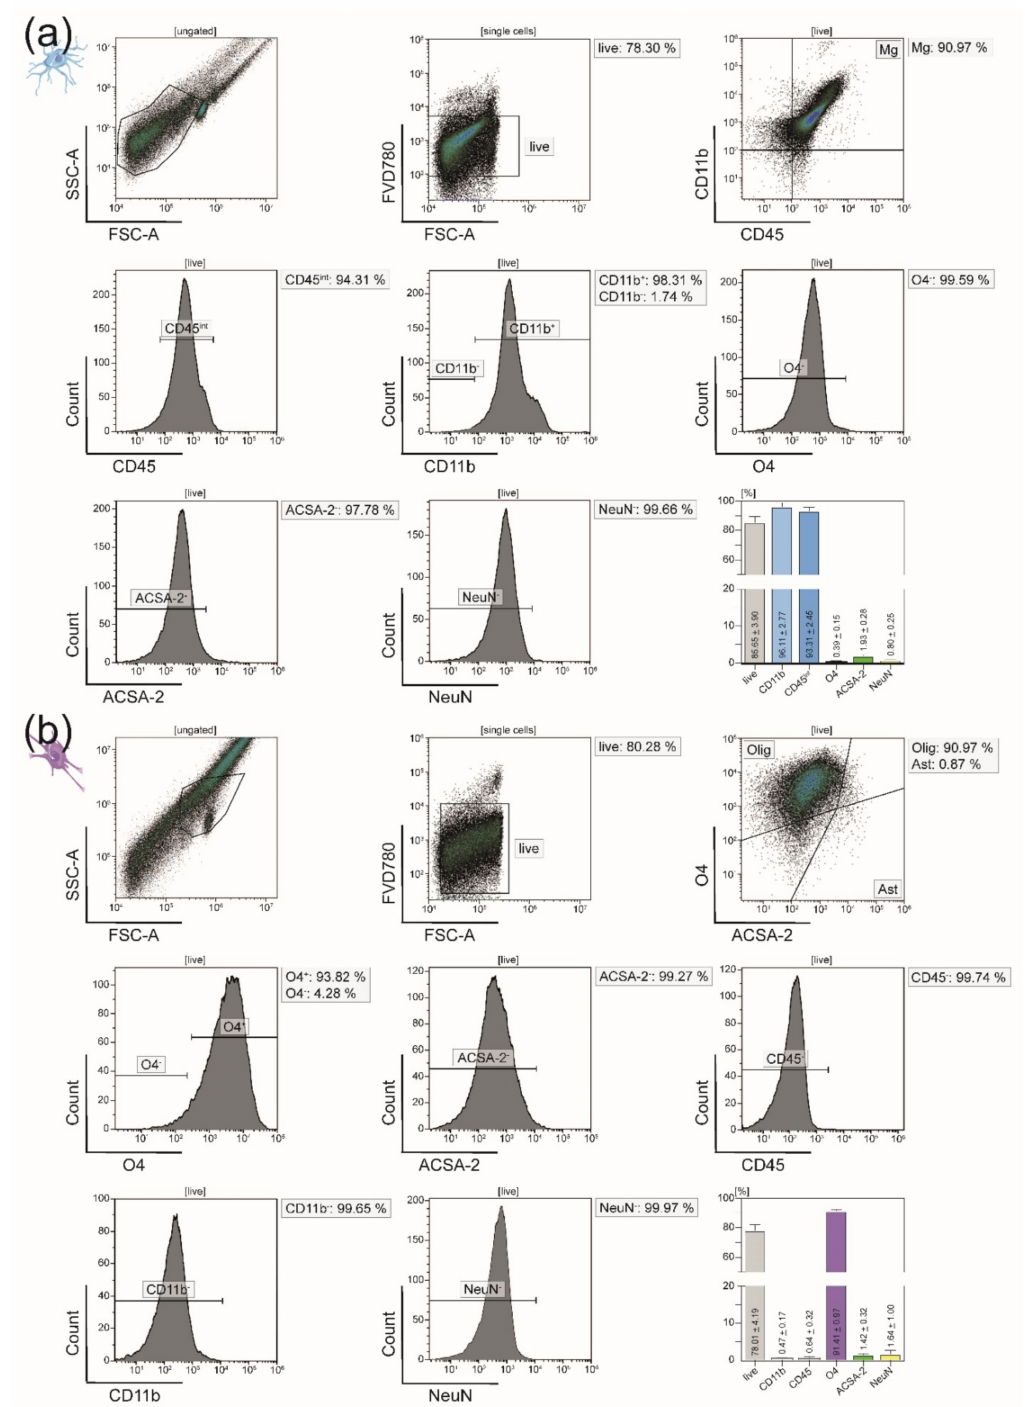
Figure 3. Flow cytometry analyses of microglia and oligodendrocytes isolated from adult naïve mice. ( a ) Exemplary purity analysis of microglia isolated from adult naïve mice via anti-CD11b MicroBeads. Microglia are CD45 int CD11b high cells and comprised 93.31% of the isolated cell fraction. ( b ) Representative purity analysis of oligodendrocytes isolated from adult naïve mice using anti-O4 MicroBeads. Of all viable isolated cells, 91.41% expressed the oligodendrocyte-specific surface marker O4. Bar graphs visualize the viability and purity of the resulting single-cell suspensions. The depicted cell-type-specific markers were selected for the purity panel of all four major CNS-resident cell types. Five biological replicates were measured for both microglia ( a ) and oligodendrocytes ( b ). Means ± SEMs are indicated within the